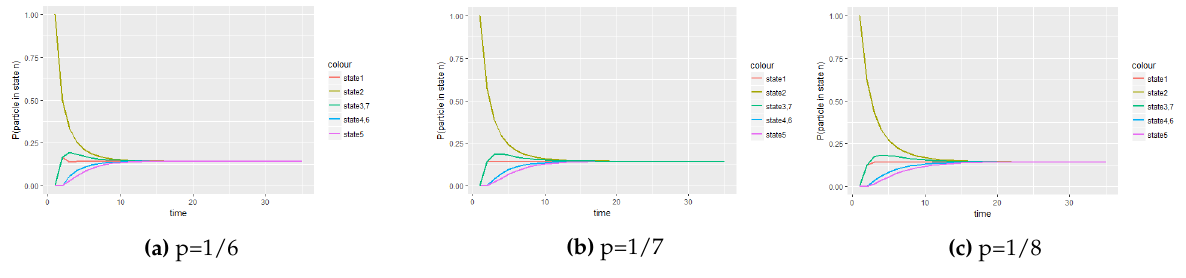
Figure 5. The panel of graphs to represent transitional probabilities against time interval of a transition matrix A with starting point at one of the border cells with with initial probability vector P 0 these graphs state 3 and 7 form one state while state 4 and 6 form a new state by overlapping because they have the same stochastic behavior to the